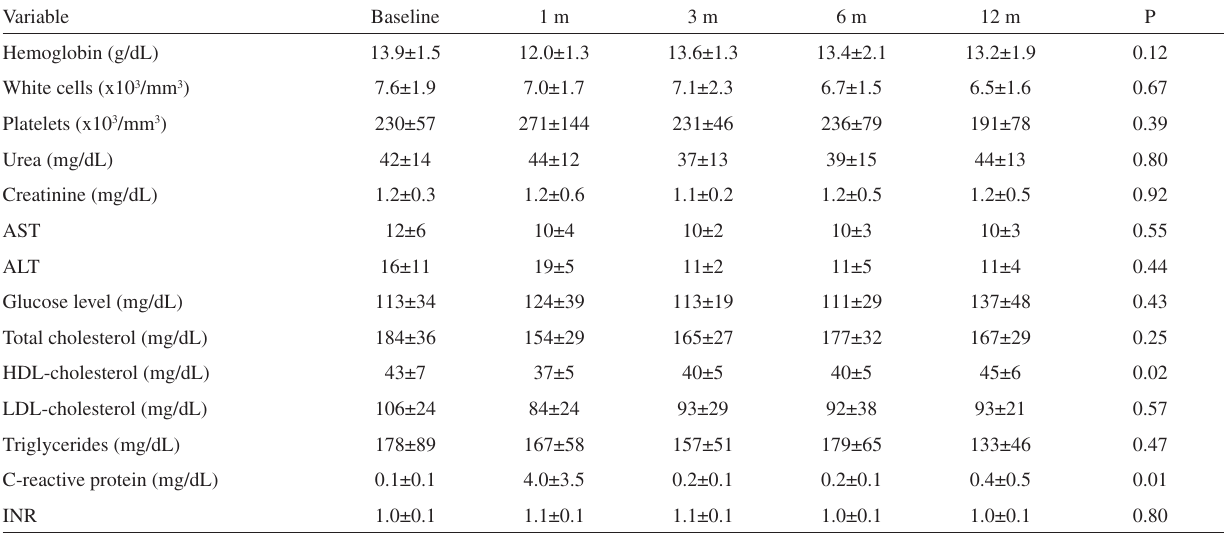
Table 4 - Selected laboratory tests at baseline and during the first year of follow-up. Variable